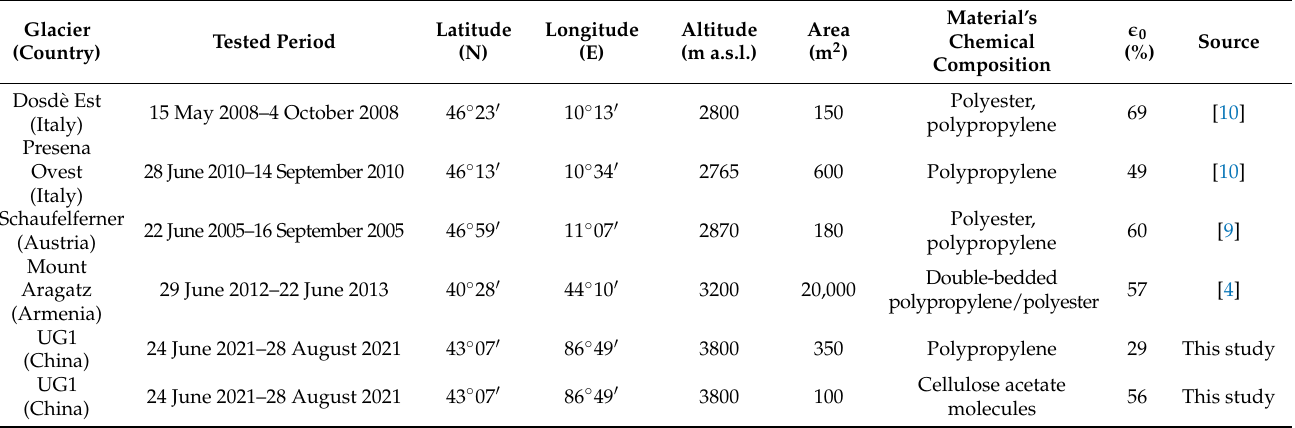
Table 2. Studies documenting local melt reduction by geotextiles. (cid:15) 0 refers to the percentage reduction in melting compared with an uncovered